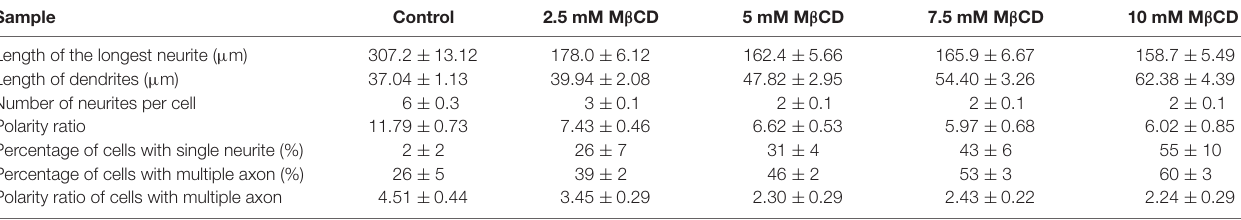
TABLE 2 | Developmental alterations of rat hippocampal neurons upon transient sequestering of cholesterol for 10 min.